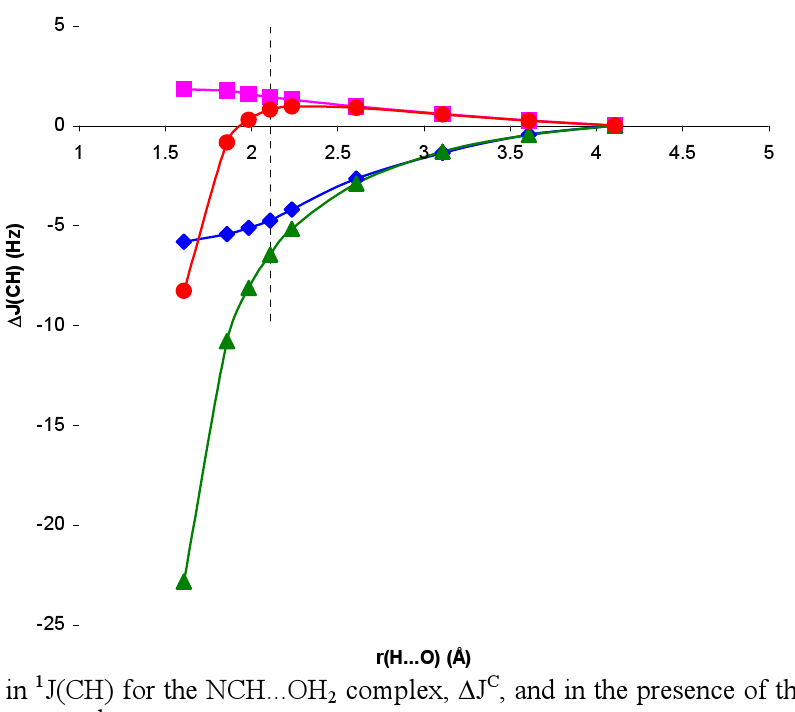
complex, ∆ J C , and in the presence of the H 2